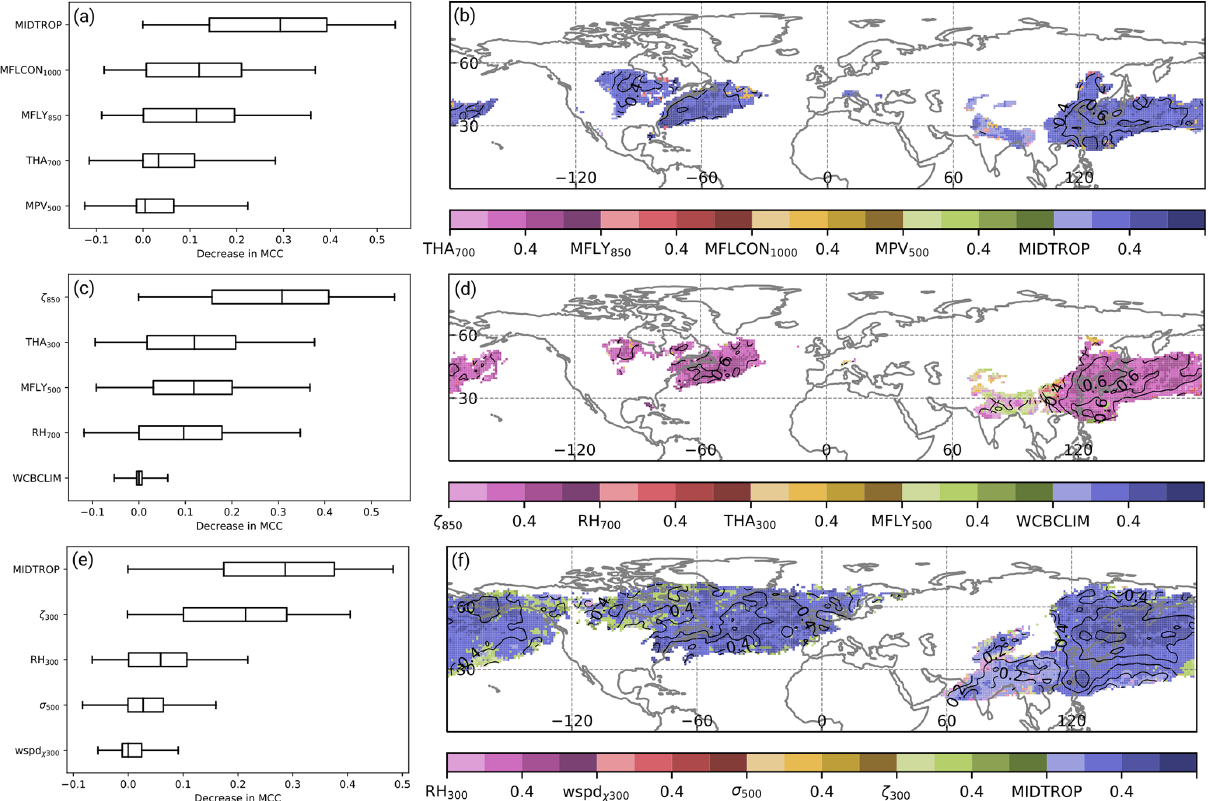
Figure 8. As in Fig. 7 except that all panels are shown for JJA in the period 1 June 2005 to 31 August